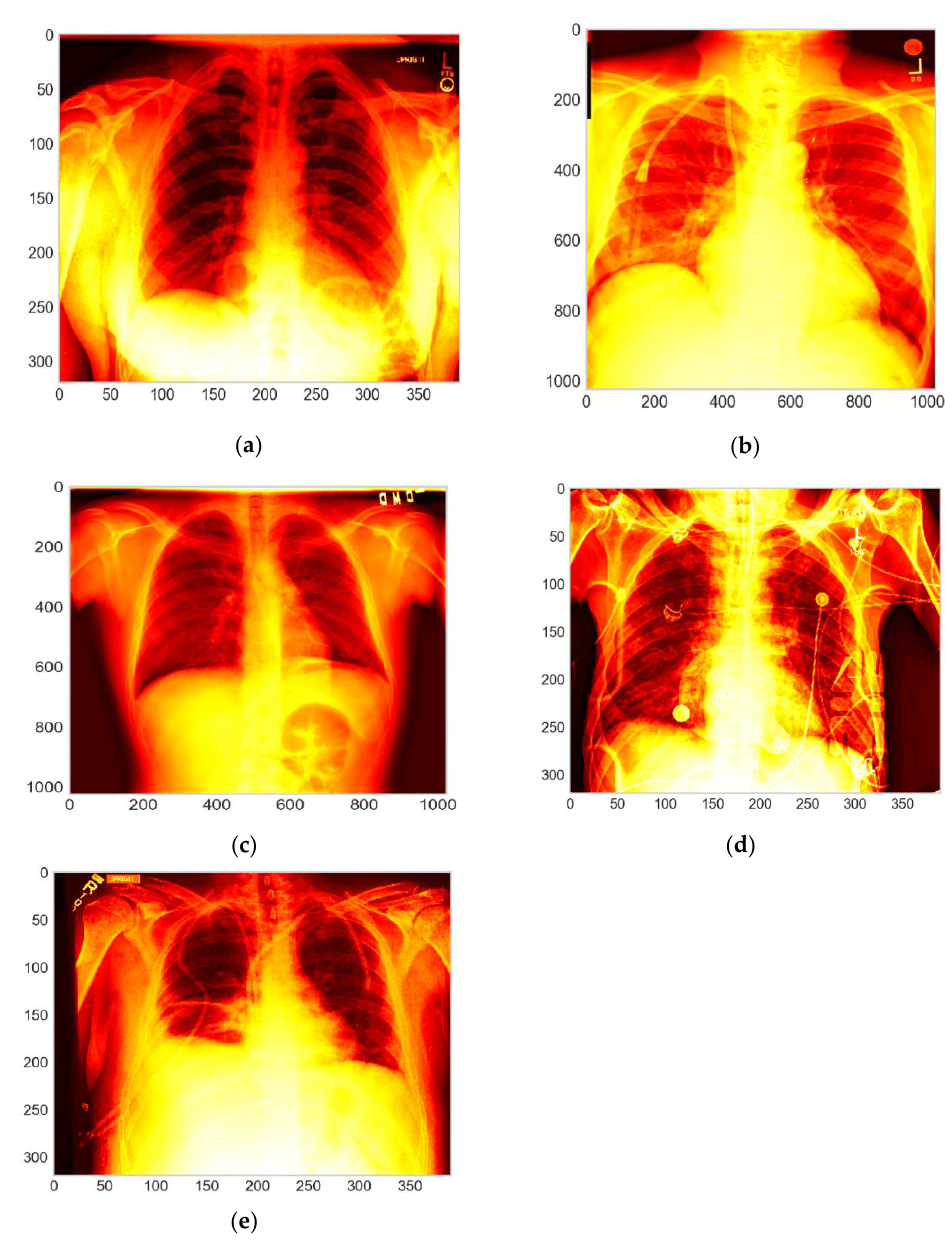
Figure 4. Chest X-rays (CXRs) of the five different lung diseases used in this work: ( a ) atelectasis; ( b ) cardiomegaly, ( c ) consolidation, ( d ) edema; and ( e ) pleural effusion.